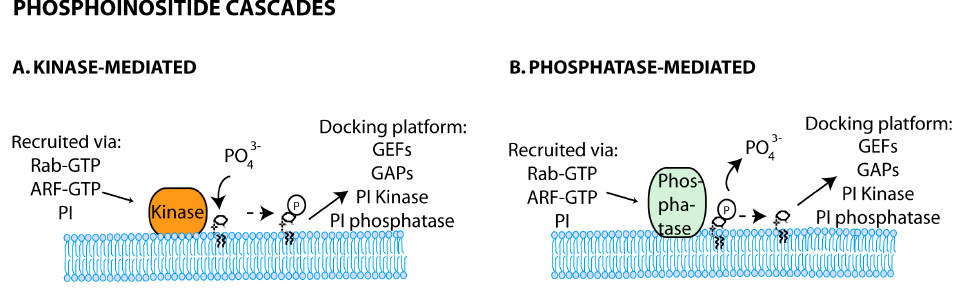
Figure 3. Phosphoinositide cascades. The phosphoinositide-mediated recruitment of kinases ( A ) or phosphatases ( B ) to act upon other phosphoinositides can initiate the formation of protein